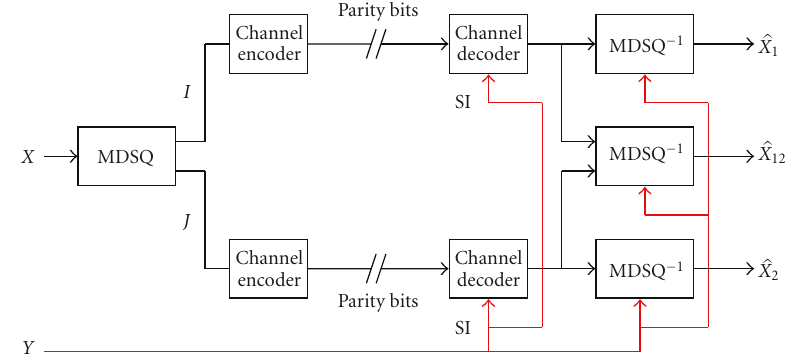
Figure 4: Implementation of the MDSQ with